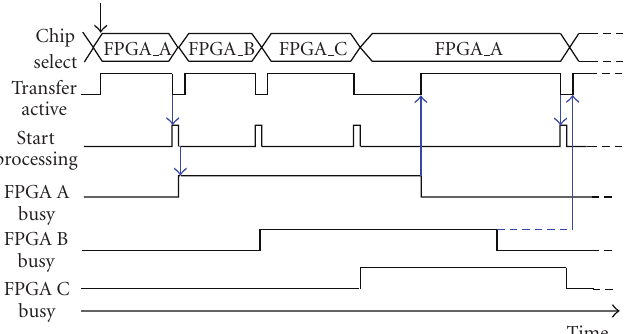
Figure 10: Test procedure after DAQ and manual reconfiguration of the Comp FPGAs via JTAG. Firstly, we supplied computing FPGA A with a set of A-Scans and started processing on this FPGA. While processing is underway, we initiated data transfer and processing on the Comp FPGAs B and C. After completion of processing on FPGA A, we transferred the resulting data back to DDRII memory and loaded further unprocessed A-Scans. This scheme is repeatedly applied.